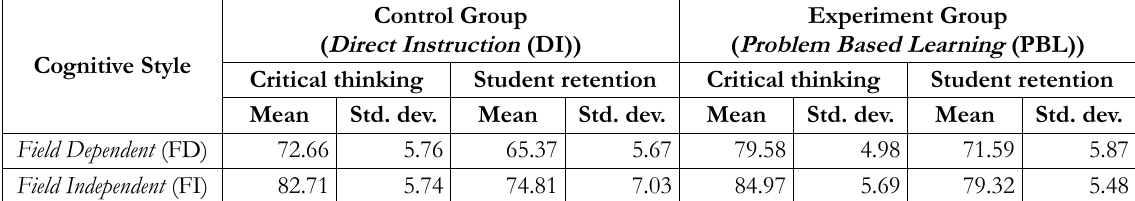
Table 8. The Final Test of Critical Thinking Skills and Student Retention Based on Cognitive